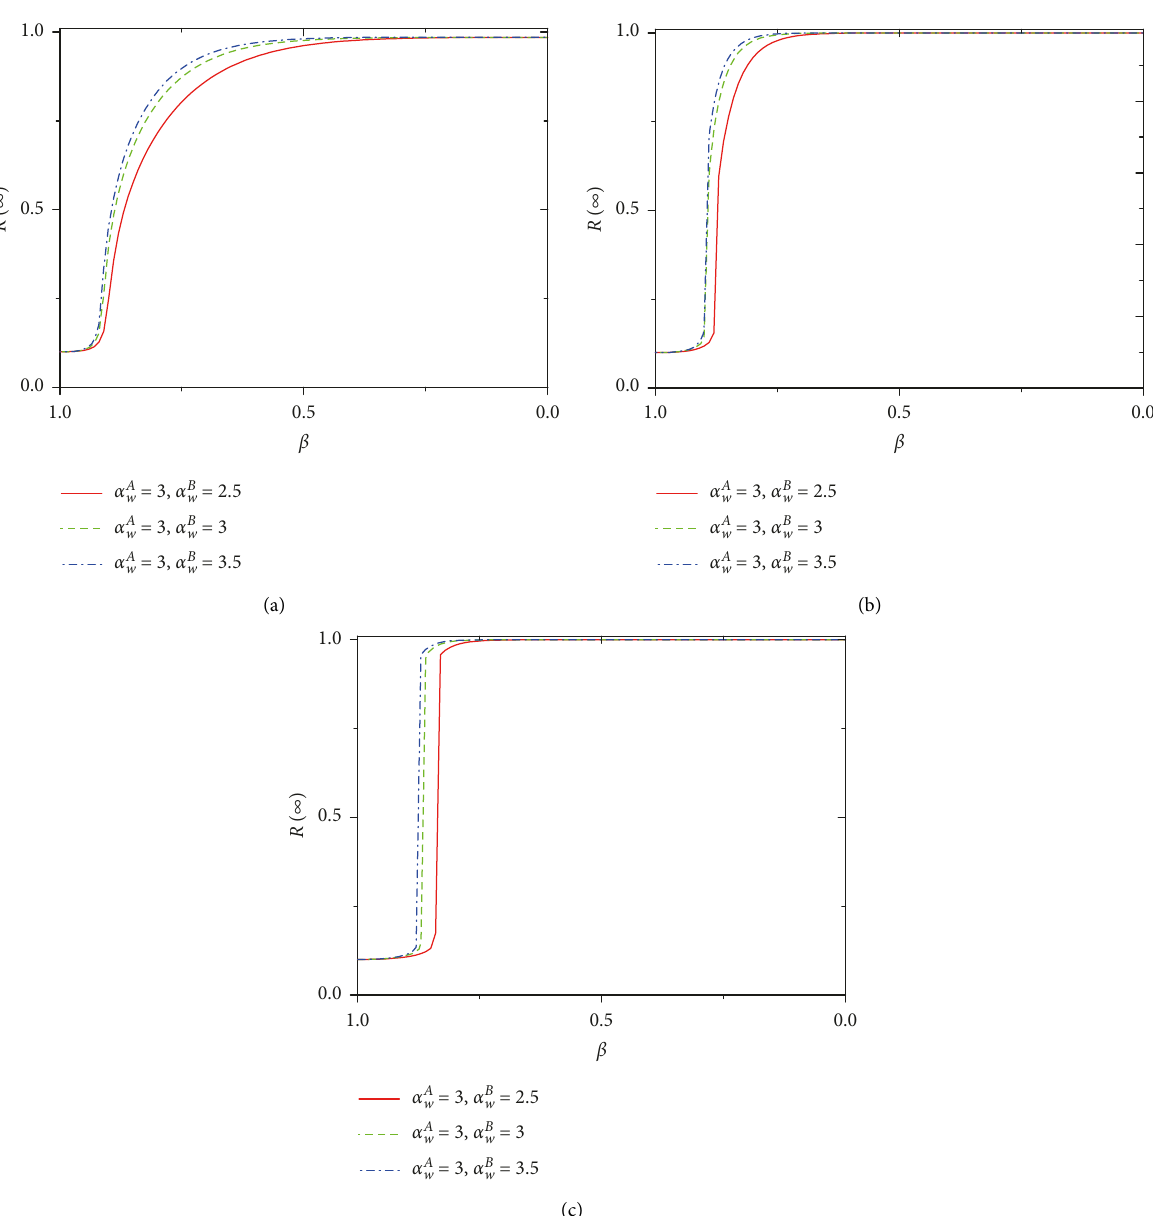
� 3, α B � 2 . 5), ( α B � 3, α B � 3), and ( α A � 3, α B � 3 . 5), respectively. ω ω ω ω ω ω